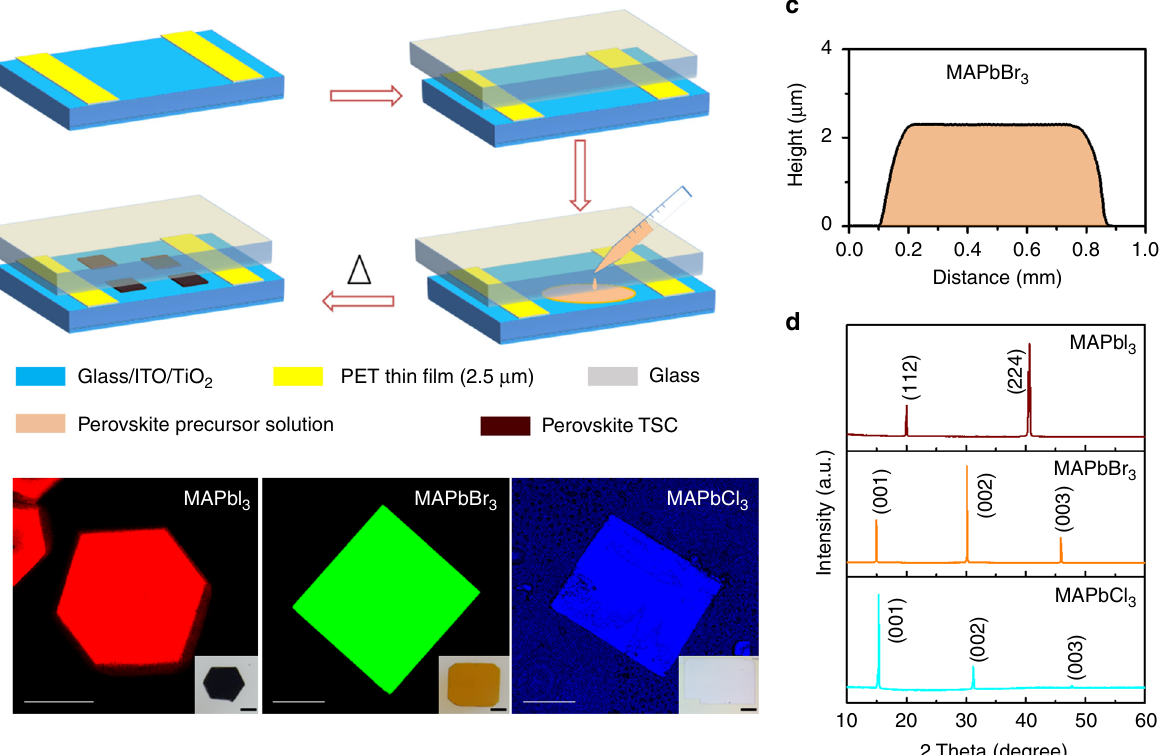
Fig. 1 Hybrid perovskite TSC fabrication. a Schematic representation of spatially con fi ned inverse temperature crystallization method for producing thin single crystals (TSCs). b Fluorescence microscopy images of MAPbI 3 , MAPbBr 3 , and MAPbCl 3 TSCs (which are excited with a pulsed 450, 473, and 405 nm laser, respectively). Scale bar: 100 μ m. Inset: optical images of MAPbI 3 , MAPbBr 3 , and MAPbCl 3 TSCs. Scale bar: 200 μ m. c Height pro fi le of MAPbBr 3 TSC indicating its thickness is about 2.45 µ m. d XRD spectra of synthesized MAPbX 3 TSCs, where X = I, Br, and Cl,